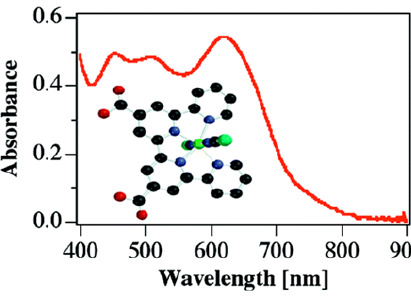
Figure 16. Visible and Near-IR spectrum of ruthenium(II) tetradentate polypyridine ligand